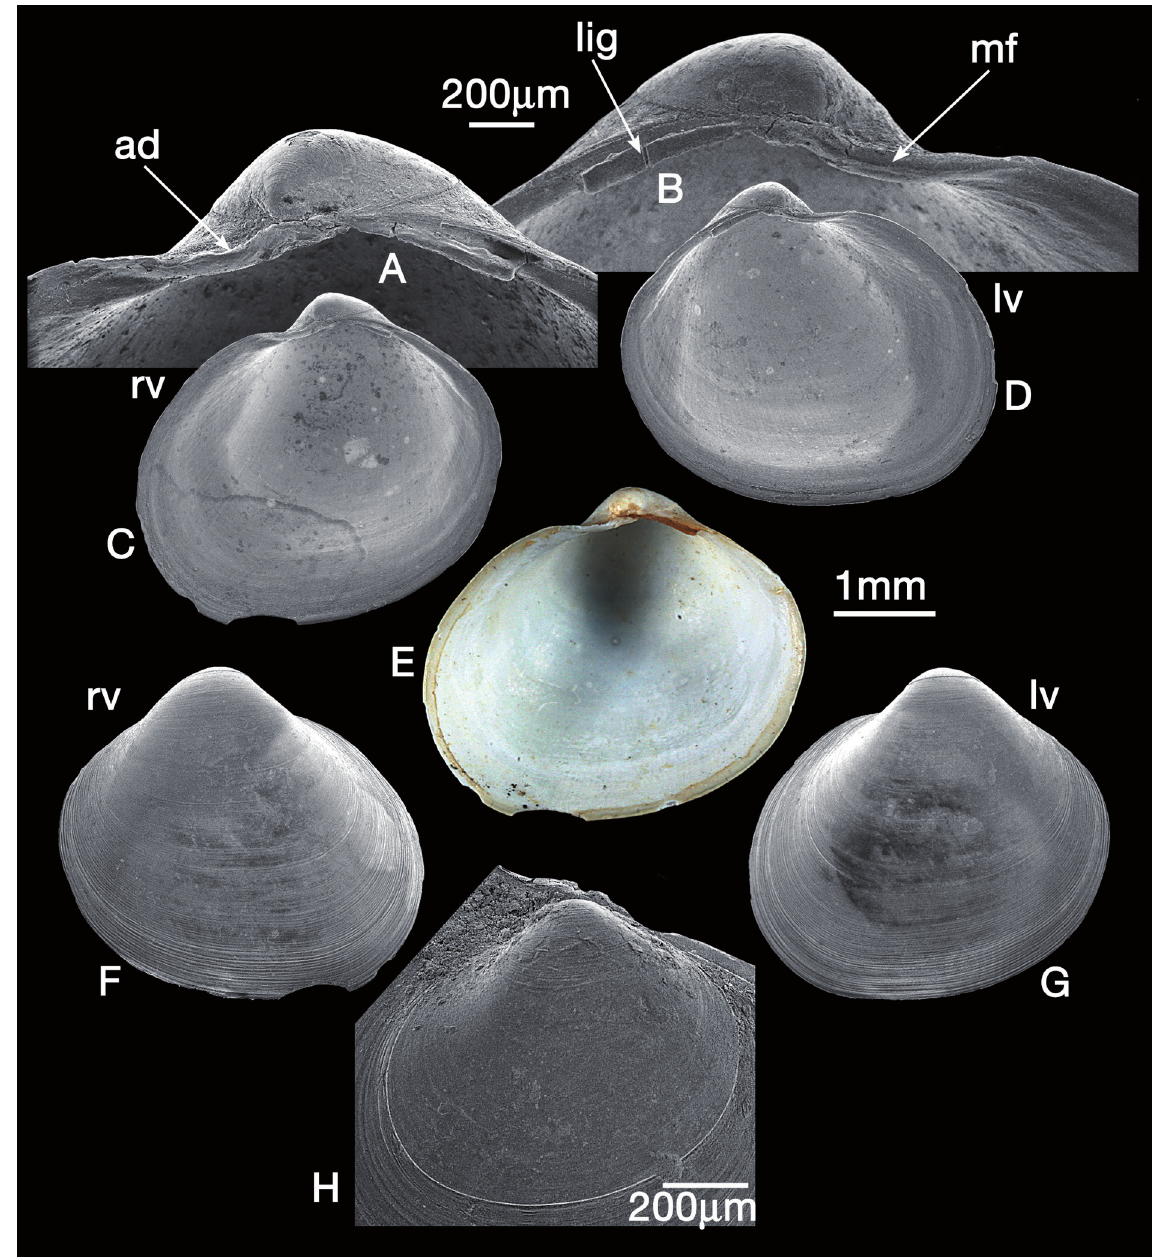
Fig. 1. Holotype of Axinodon symmetros Verrill & Bush, 1898, USNM 35175. A-B . SEM of hinges of right and left valves. C-D . SEM of internal of right and left valves. E . Photo micrograph of internal of right valve. F-G . SEM of external of right and left valves. H . SEM of